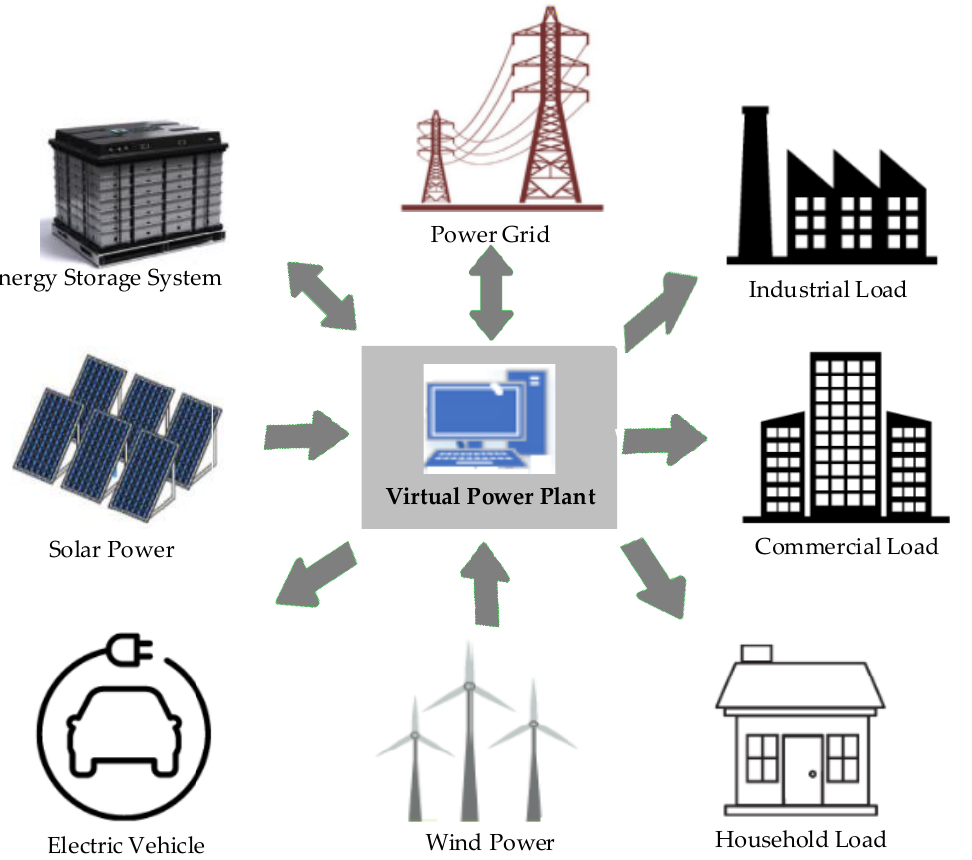
Figure 1. A generic structure of a virtual power plant.